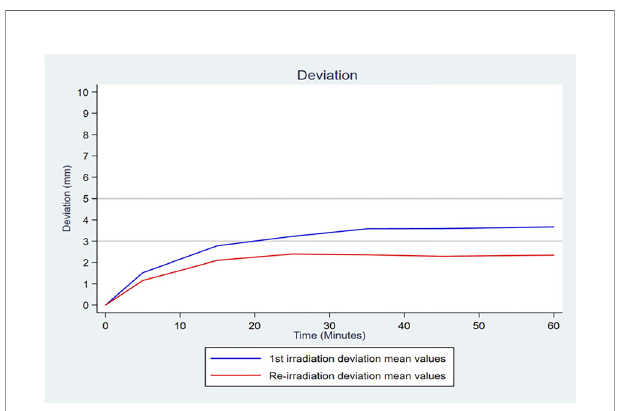
FIGURE 1 | Curve of the mean deviation per 10-minute interval in each treatment group (primary irradiation and re-irradiation).